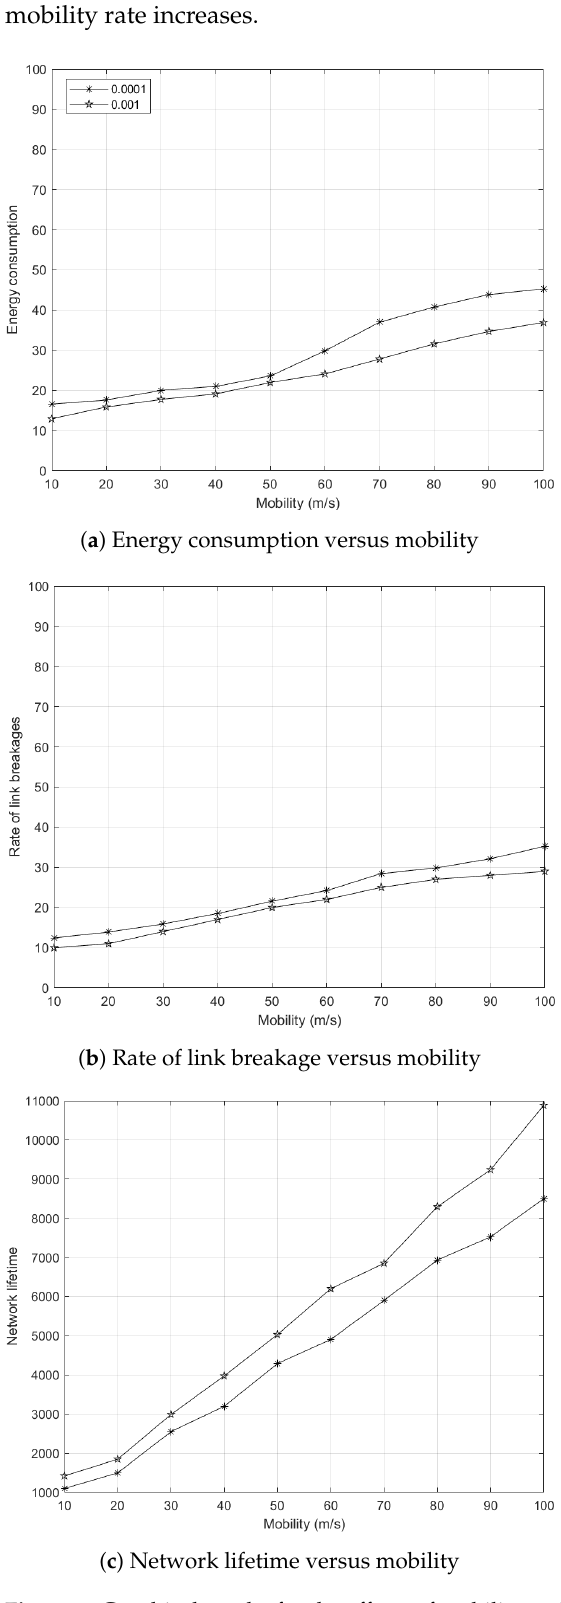
Figure 7. Graphical results for the effects of mobility on DQN. Learning rate α = 0.001 achieves the lowest energy consumption and rate of link breakages, as well as the highest network